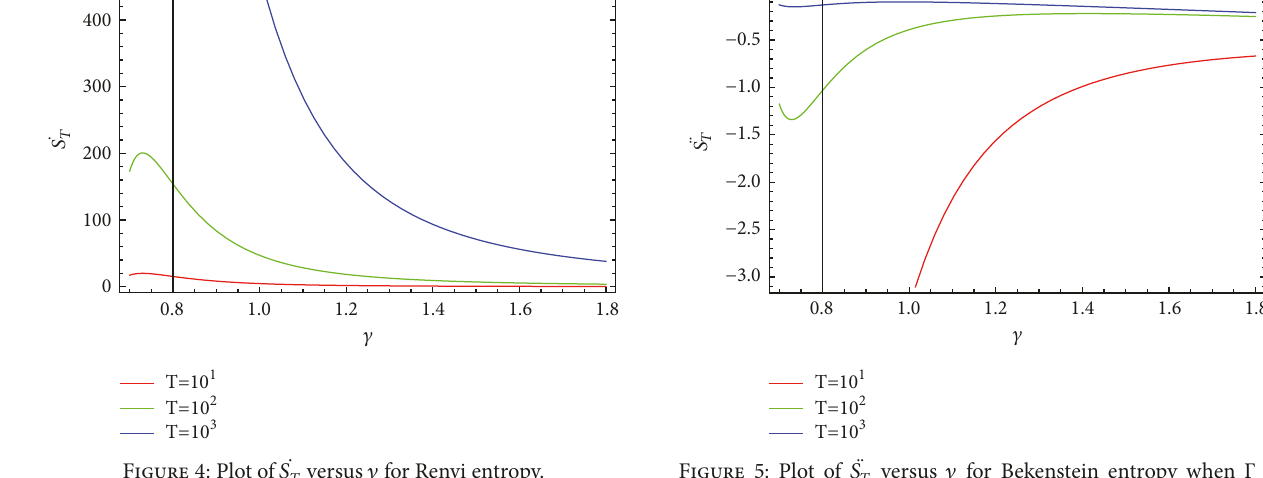
Figure 5: Plot of